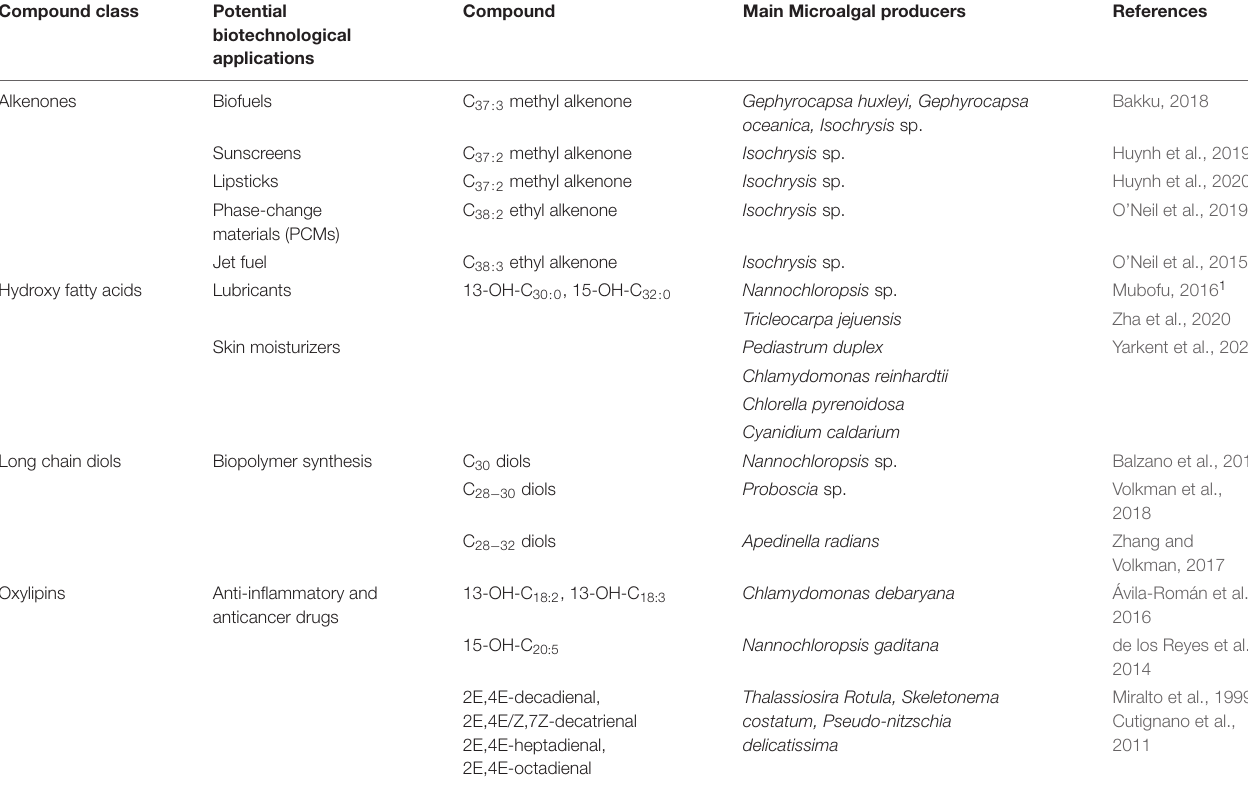
TABLE 2 | Microalgal fatty acid derivatives of biotechnological